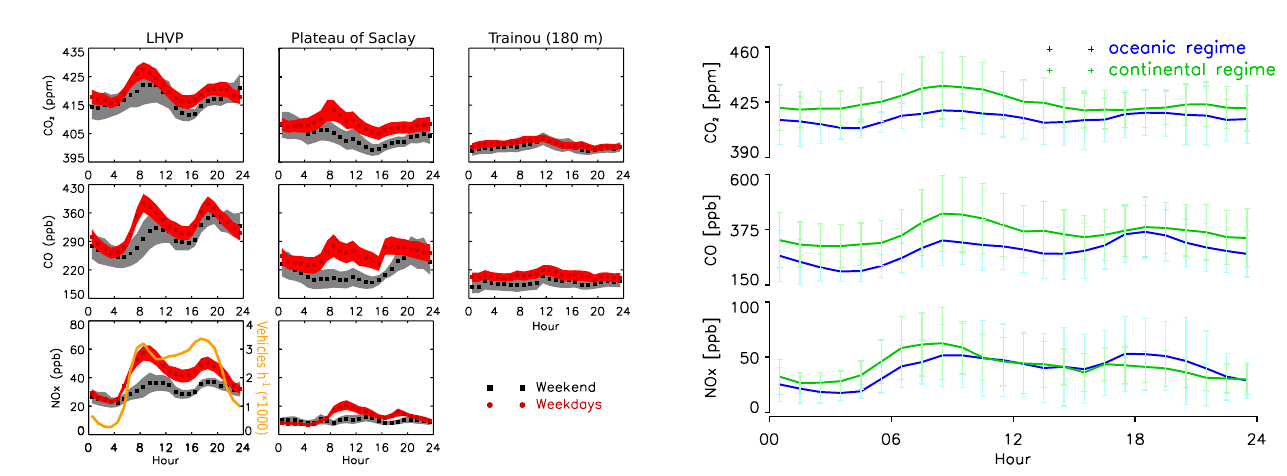
Fig. 5. The CO 2 , CO and NO x diurnal cycles at the LHVP as a func- tion of the air mass regime. The green curves correspond to the con- tinental regime, whereas the blue curves correspond to the oceanic regime. The error bars represent the standard deviation of the